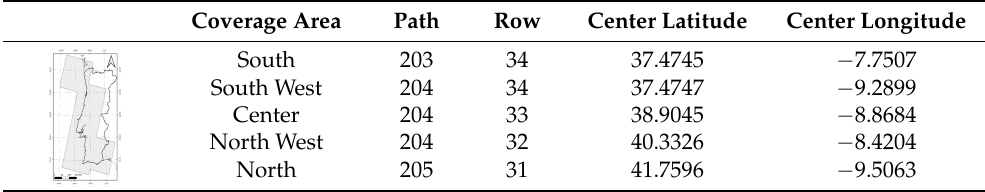
Table 1. Landsat 8 scenes acquired for regional analysis in the coastline of Portugal (map) and data acquisition details. Coverage Area Path Row Center Latitude Center Longitude